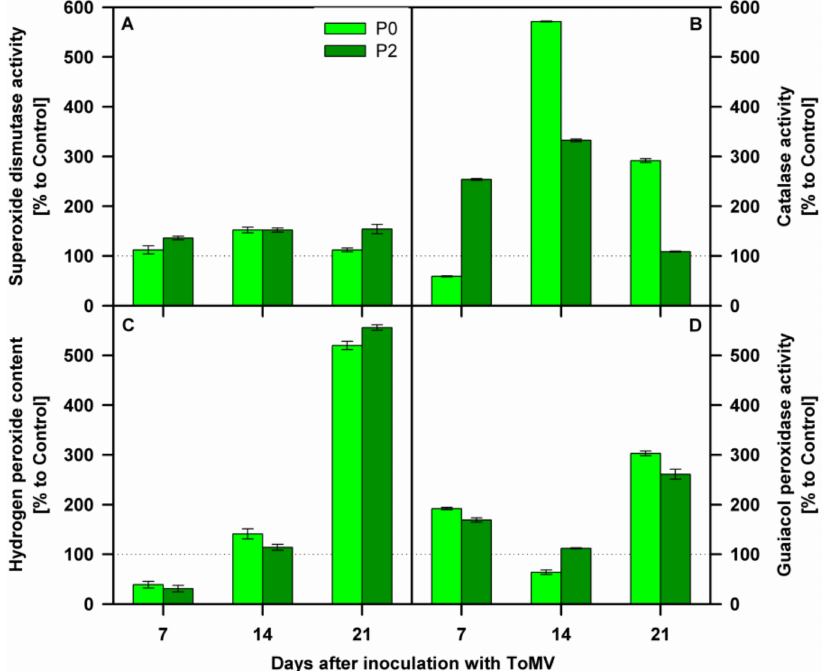
Figure 5. Mean ( ± SE) percentage of the activity of superoxide dismutase ( A ); Activity of catalase ( B ); Content of hydrogen peroxide ( C ); Activity of guaiacol peroxidase ( D ) in tomato plants cv. Moperou inoculated with ToMV incompatible strain (GM-0) P0, and compatible (J) strain P2 (7, 14, and 21